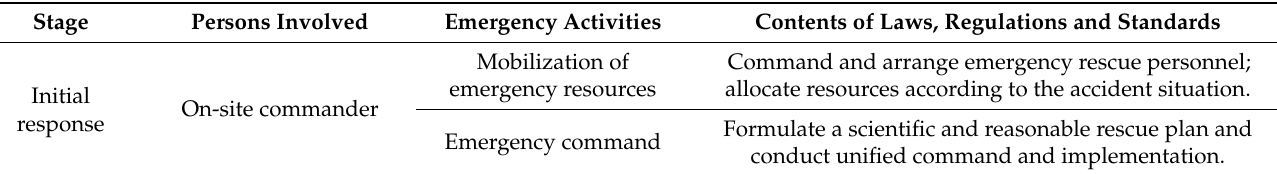
Table 2. Emergency activities in laws, regulations and